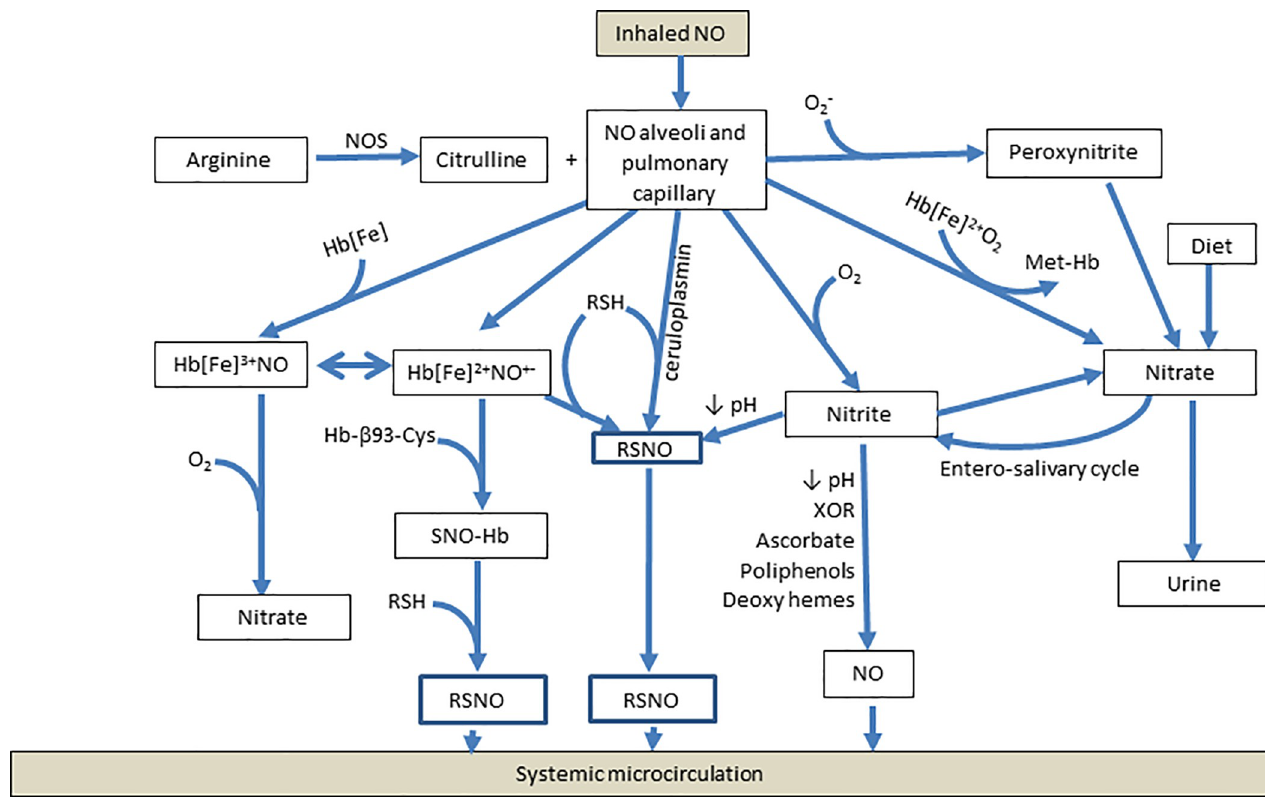
Fig 2. Mechanisms by which inhaled NO acts on the systemic microcirculation. Abbreviations: Hb: hemoglobin, Hb:[Fe]NO: nitrosyl Hb, Met-Hb: methemoglobin, NO: nitric oxide, NOS: nitric oxide synthase, O 2 : oxygen, ROS: reactive oxygen species, RSH: alkyl thiols, RSNO: S nitrosothiols, SNO-Hb: S- nitrosothiol Hb, XOR: xanthine